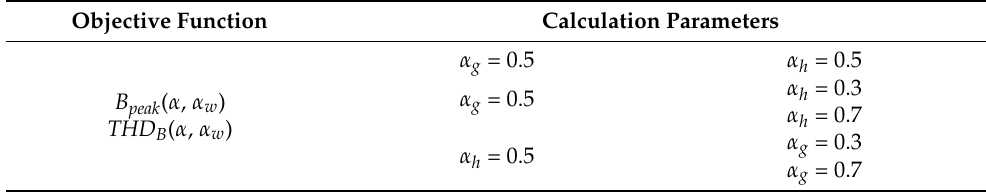
Table 2. Analysis scheme of the objective function and calculation